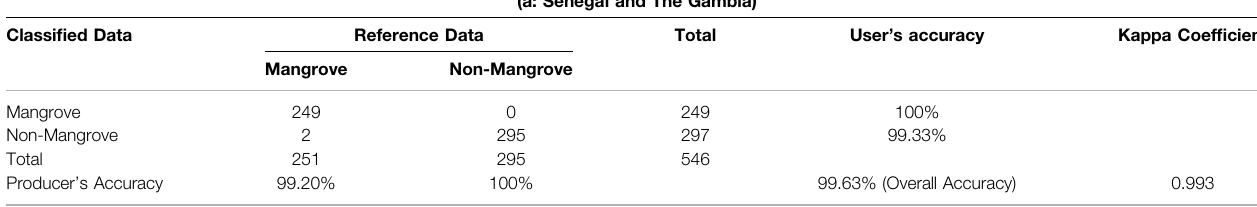
TABLE 2 | Quantitative accuracy assessment for the machine learning ensemble performance and related mangrove extent data product: confusion matrix for (a) Senegal and The Gambia, (b) Guinea-Bissau, (c) Guinea, (d) Sierra Leone, (e) Liberia, (f) C ˆ ote d ’ Ivoire, (g) Ghana, (h) Togo and Benin, and (i) Nigeria. (a: Senegal and The